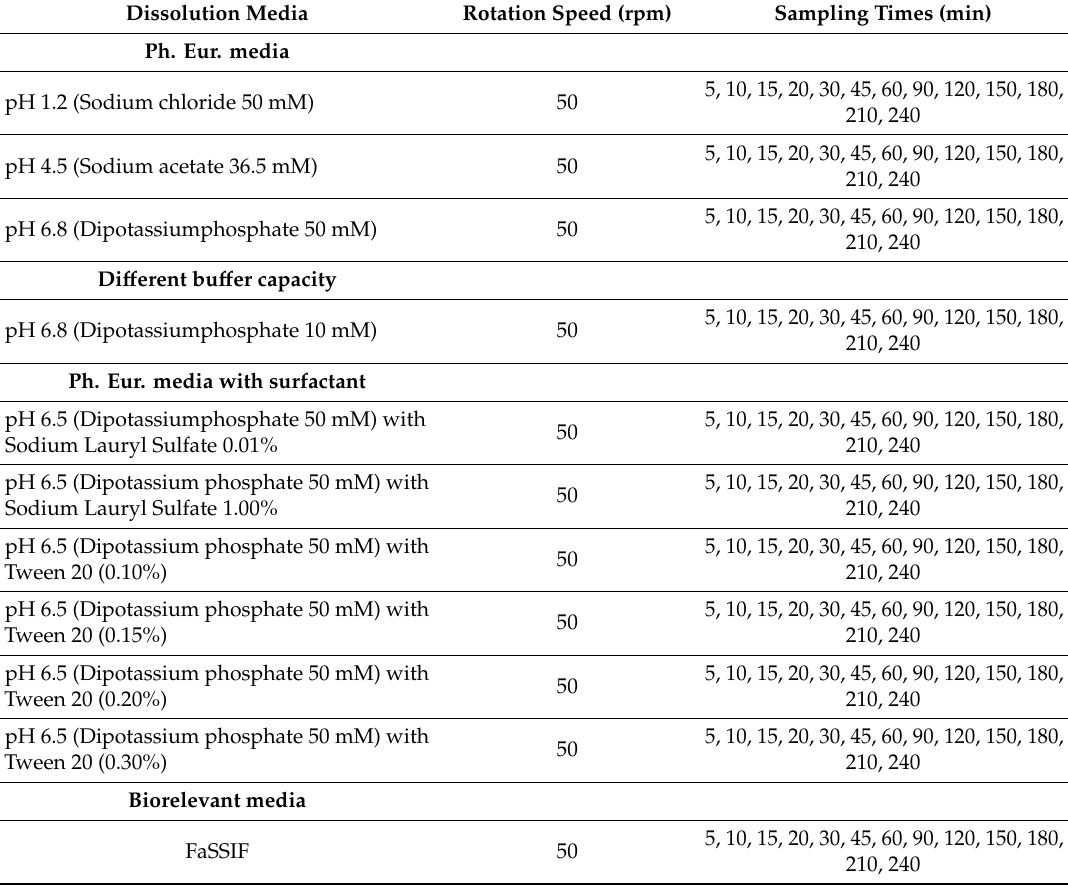
Table 2. Characteristics of the dissolution experiments conducted in USP II (Dissolution media, paddle rotational speed and sampling